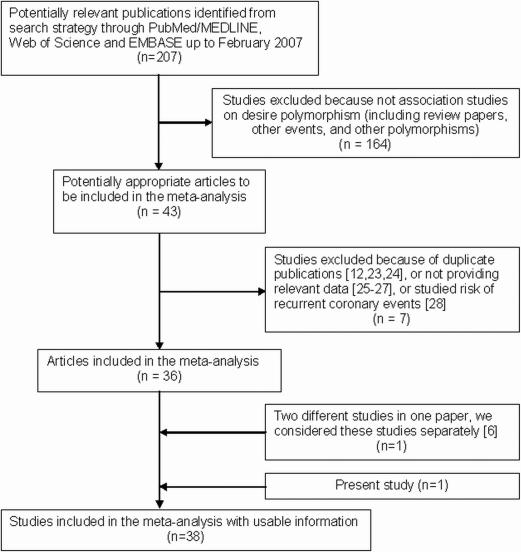
Flow chart of study selection.